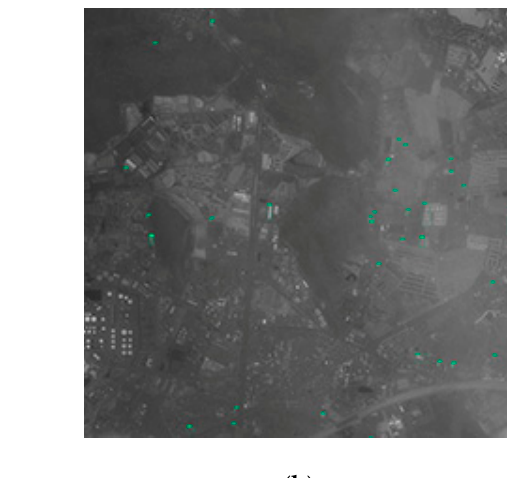
Table 9. Results and time spent of detection of the second JL-1 image.